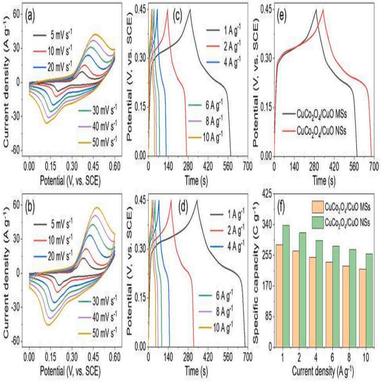
The electrochemical tests in three-electrode system: the CV curves of (a) CuCo2O4/CuO microspheres and (b) CuCo2O4/CuO nanosheets at the scan rate from 5 to 50 mV s − 1 , the GCD curves of (c) CuCo2O4/CuO microspheres and (d) CuCo2O4/CuO nanosheets at the current density from 1 to 10 A g− 1 , (e) the GCD profiles of the CuCo2O4/CuO microspheres and CuCo2O4/CuO nanosheets at 1 A g− 1 , and (f) the rate performance of CuCo2O4/CuO microspheres and CuCo2O4/ CuO nanosheets.